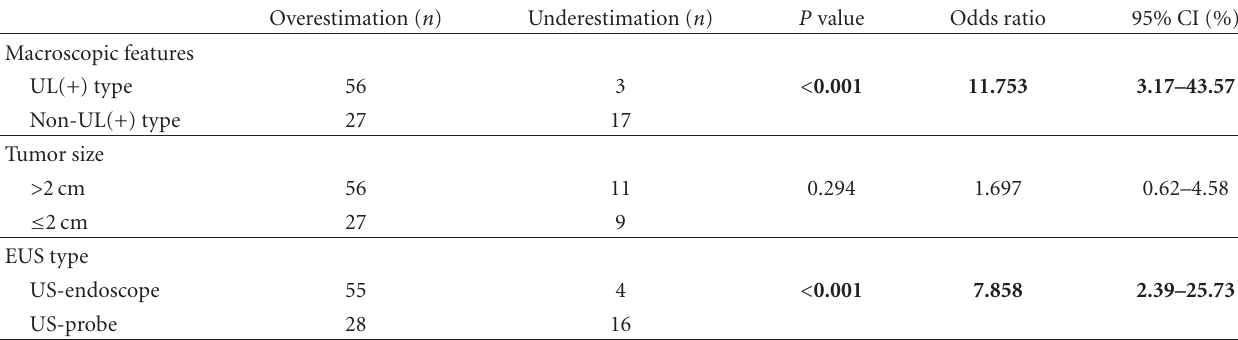
Table 6: Causes of m/sm1 cancer being classified as EUS-SM2 or deeper. Wrong evaluation of ulcerative change 44 (65.6%) Presence of cystic change beneath the lesion 2 (3.0%) Unknown 21 (31.3%) m/sm1 refers to histologically determined depths and EUS-SM2 or deeper refers to depths of EGC invasion determined by EUS (see text for full